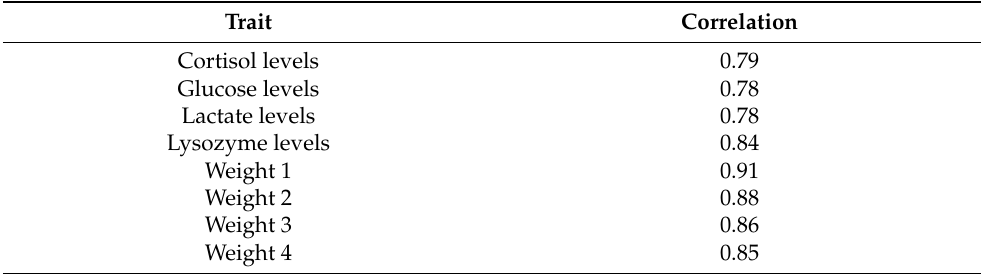
Table 8. Correlation between Estimated Breeding Values (EBVs) and Genomic Estimated Breeding Values (GEBVs) for the Body weight and stress indicators. Trait Correlation Cortisol levels 0.79 Glucose levels 0.78 Lactate levels